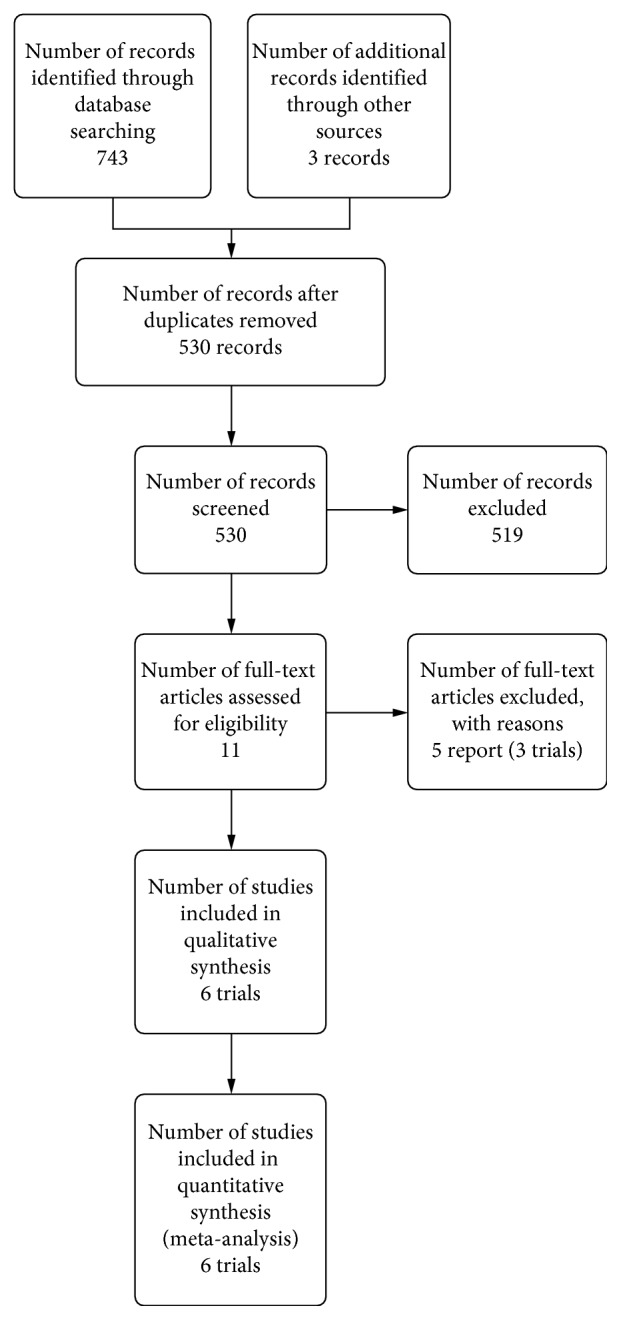
PRISMA flow diagram.